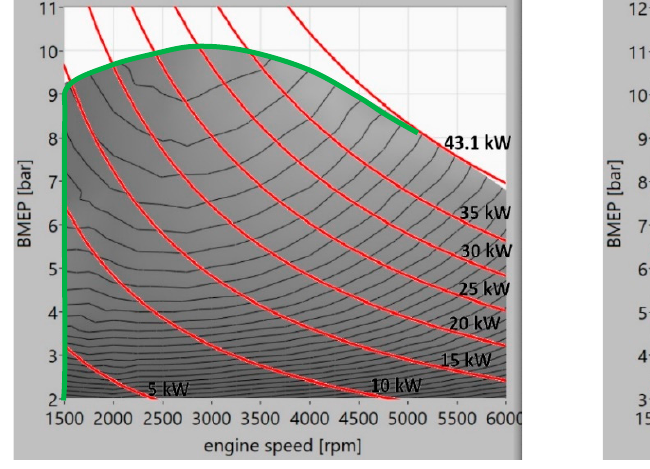
Figure 7. The hydrogen ‐ engine BTE map with the BEP in green.